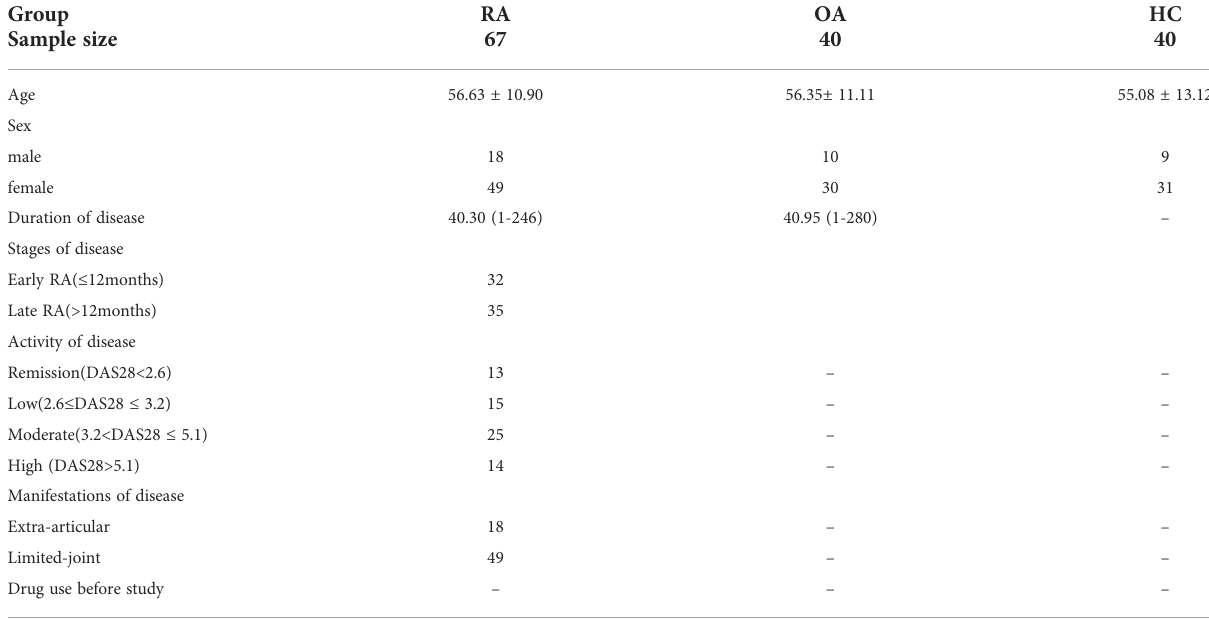
TABLE 1 Clinical features of the RA patients, OA patients and healthy controls recruited in this study.